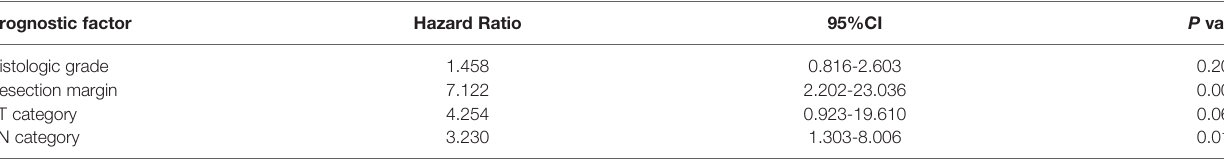
TABLE 4 | Multivariate analysis in regard to overall survival for 58 patients with EMEC. Prognostic factor Hazard Ratio Histologic